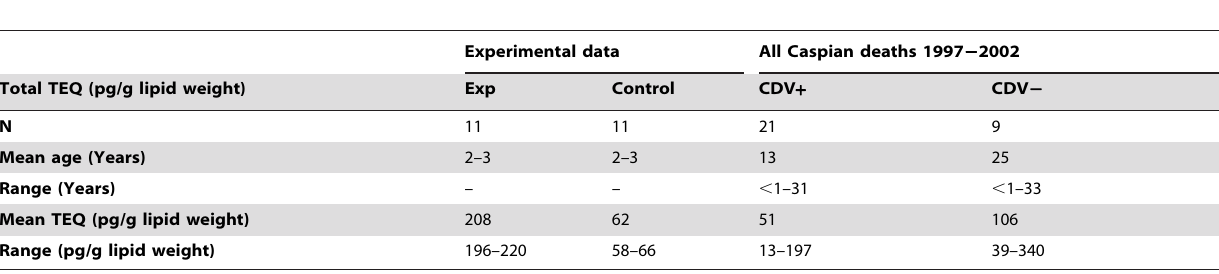
Table 5. Comparison of Total TEQs in Caspian seals dying in 2000 with seals in the Netherlands feeding experiment (experimental data from Ross et al., 1995; Caspian data from Kajiwara et al. 2002; Kuiken et al. 2006).